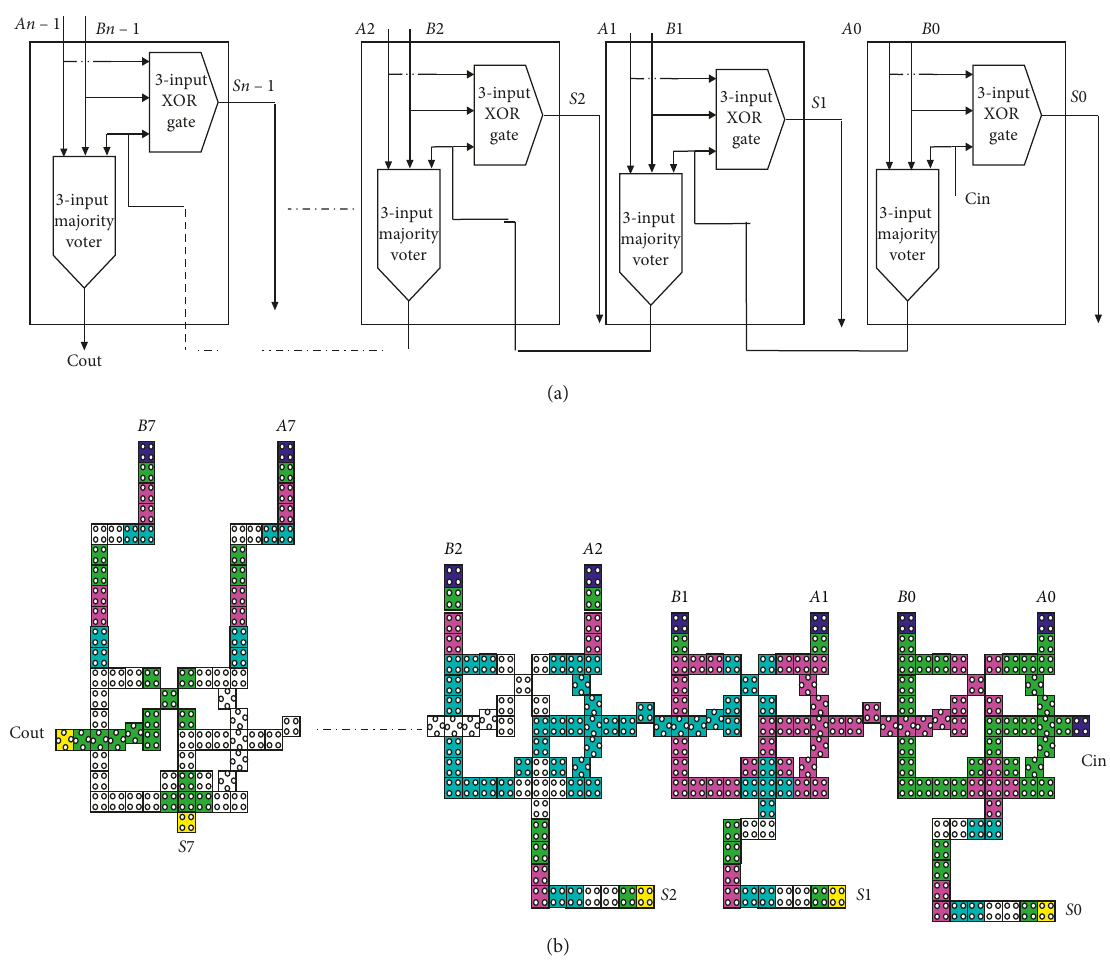
Figure 9: Proposed (a) logical diagrams and (b) QCA layouts of 8-bit parallel binary full adder.